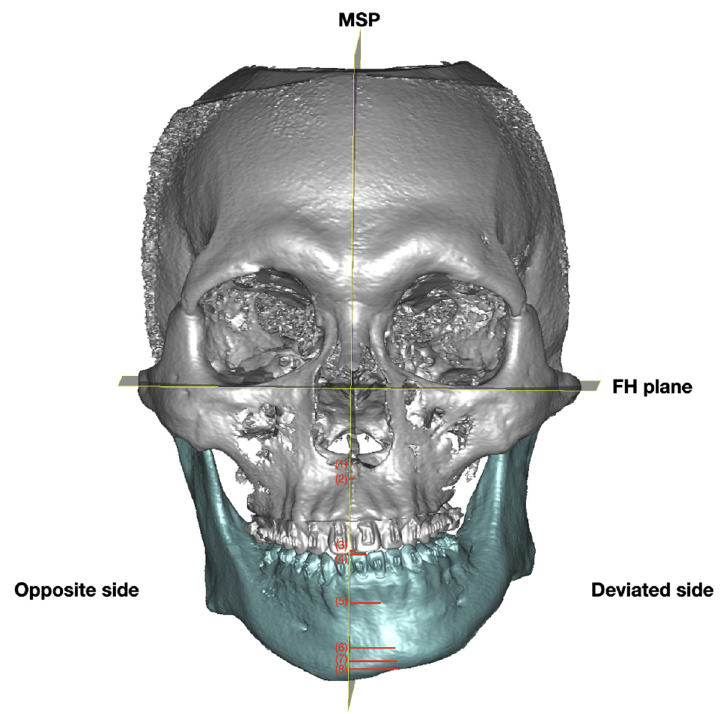
Figure 2. Midline measurements in the frontal view. The MSP separated the face into deviated and opposite sides. The deviated side was defined as the side of the face, including the skeletal menton, and the opposite side was the contralateral half. (1) ANS to MSP, (2) A point to MSP, (3) U1 to MSP,